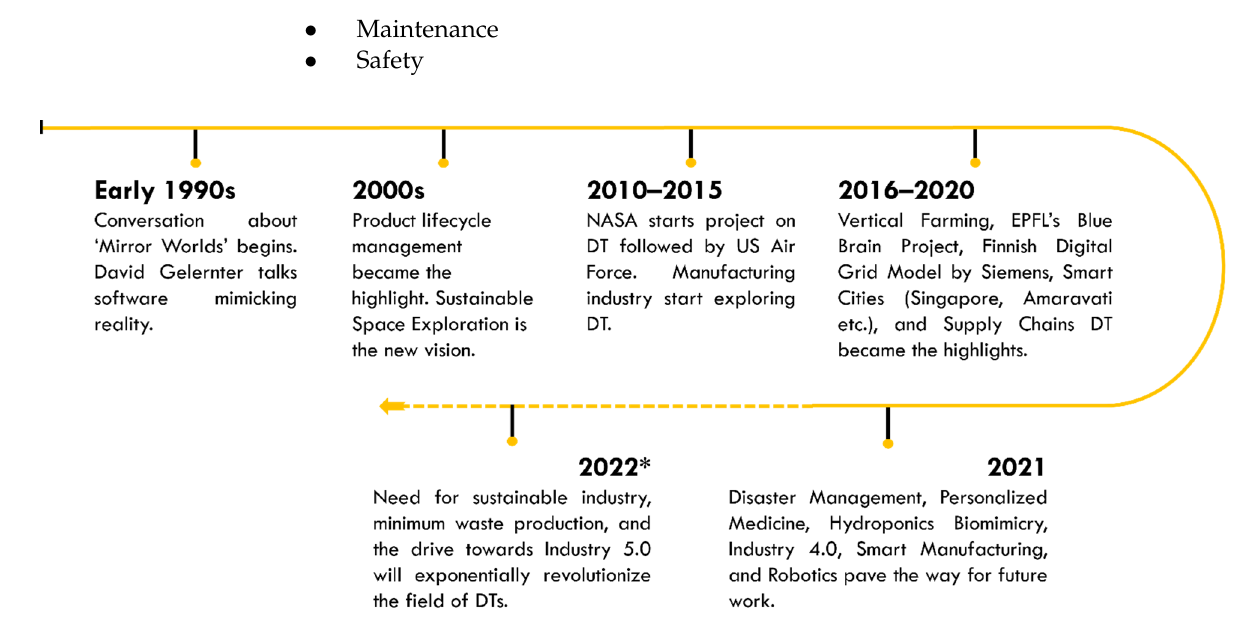
Figure 5. Evolution of DT applications (2022*). Table 3. Applications and advantages of DTs in different sectors/industries.